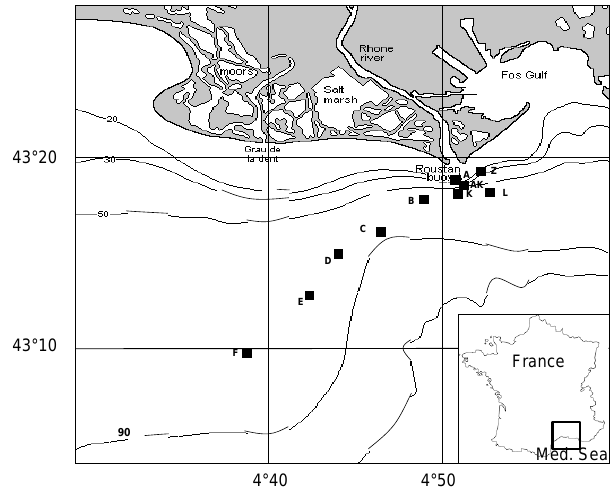
Figure 1. Map of the Rhône River mouth (northwestern Mediter- ranean Sea) with the stations investigated during the DICASE cruise in June 2014. The ocean bathymetry (inm) is indicated by the con- tinuous